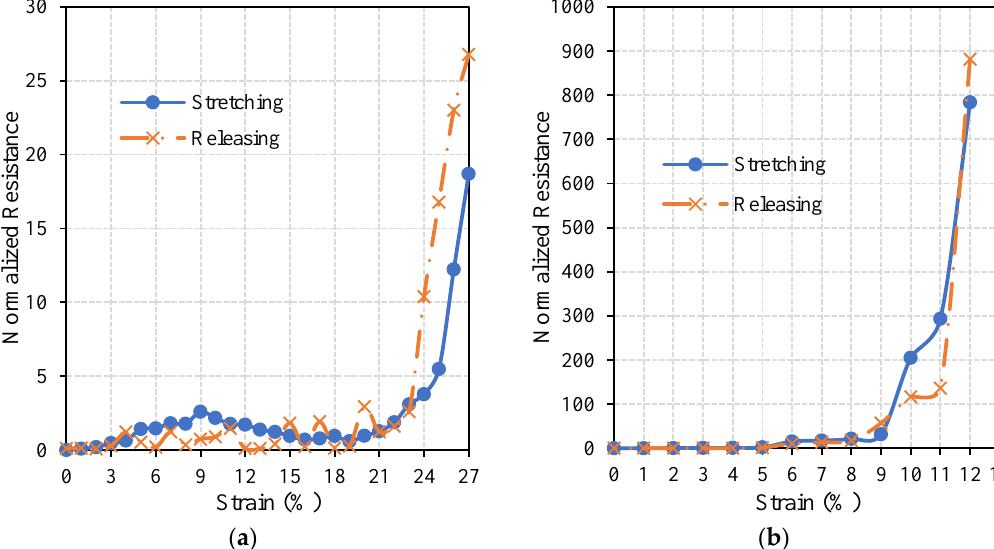
Figure 10. The change in the normalized resistance of the straight line printed on an axially pre-stretched circuit by 35% under ( a ) axial, and ( b ), radial loads.